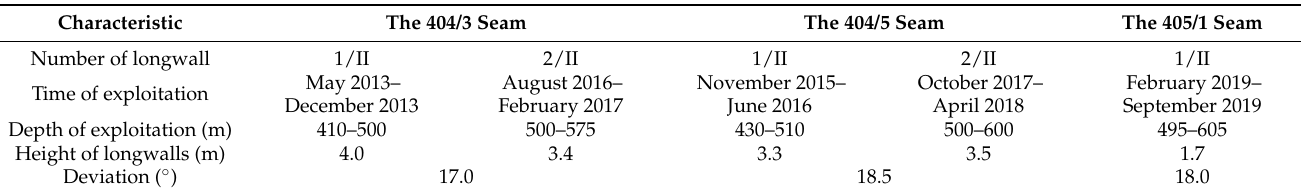
Table 1. Characteristics of exploitation of the 404 and 405 hard coal seams in the years 2013–2019.